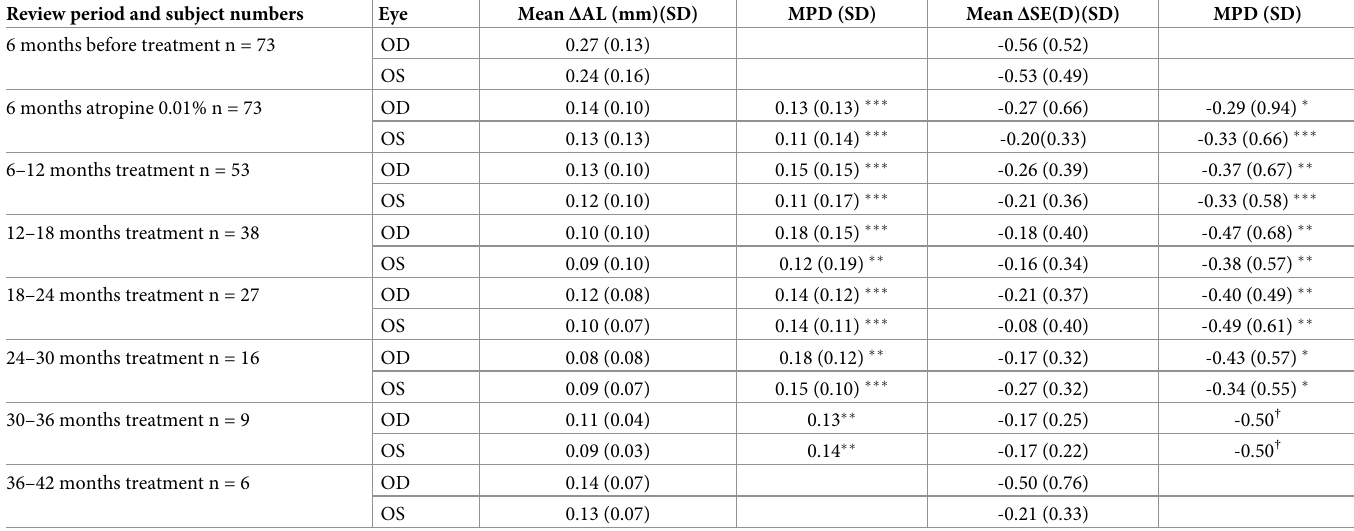
Table 2. Progression of atropine 0.01% treatment